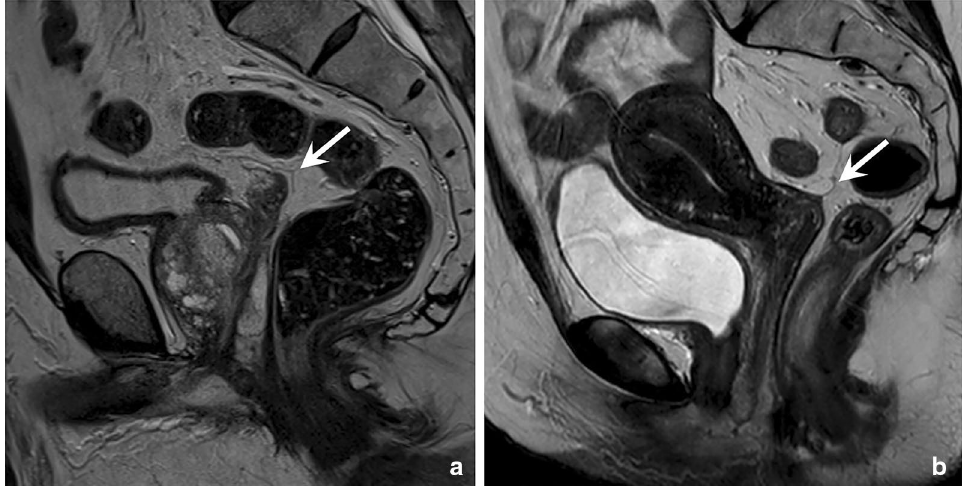
Fig. 7 Sagittal T2‑weighted MR images demonstrating the anterior peritoneal reflection in a male individual (without rectal cancer), at the top of the seminal vesicles ( a ) and in a female (without rectal cancer) where it is located at the level of Douglas’ pouch ( b ). The peritoneal reflection can